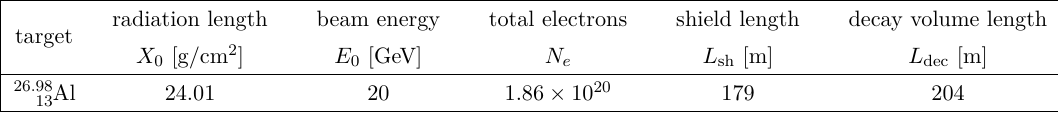
Table 1 . Setup of the E137 experiment.